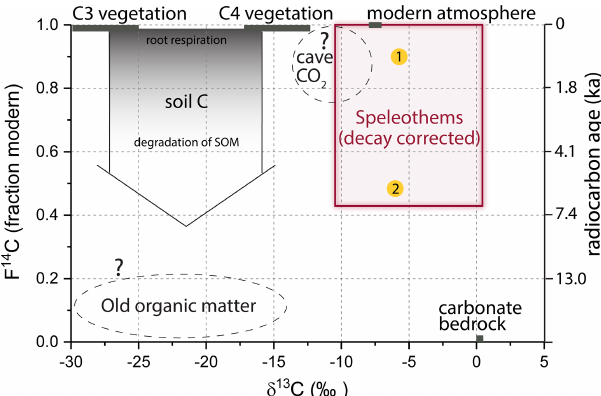
Figure 1. Carbon isotopic signatures of carbon-bearing reservoirs in karst systems. Yellow circles mark speleothem C resulting from different processes: (1) CaCO 3 dissolution via soil CO 2 -derived carbonic acid; (2) deep organic carbon contribution to seepage wa- ter feeding speleothems (adapted from Fairchild and Baker,